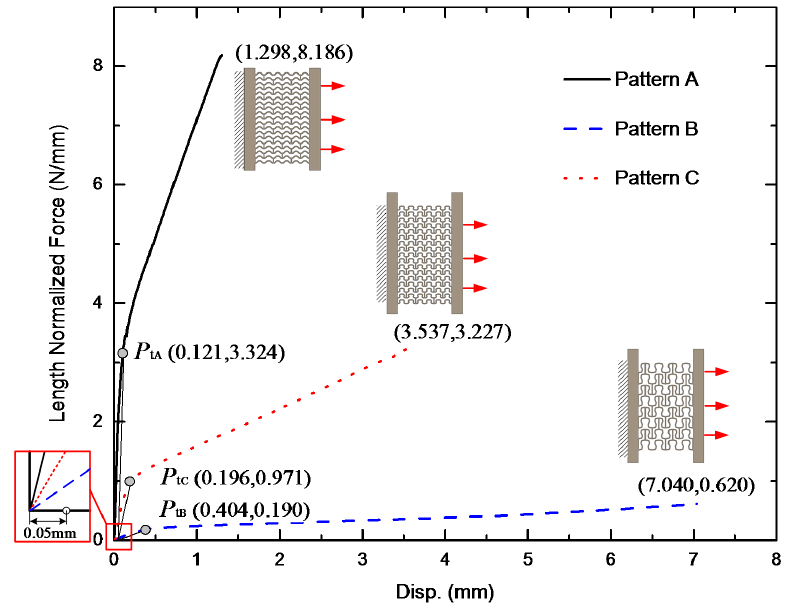
Figure 10. Length-normalized force-displacement curves of the planar specimens during the stretching tests.